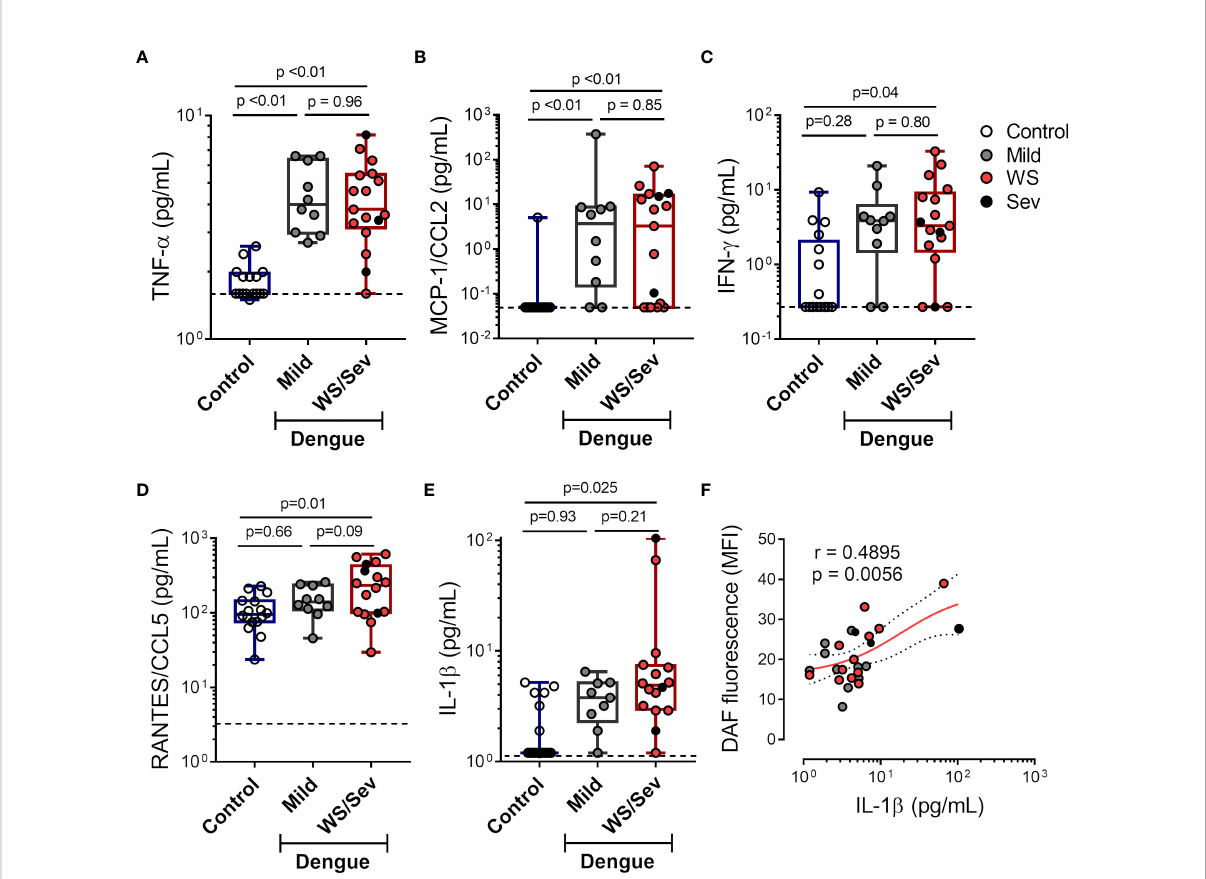
FIGURE 4 Increased levels of pro-in fl ammatory cytokines in plasma from dengue patients. The concentrations of (A) TNF- a (B) MCP-1/CCL2 (C) IFN- ɣ (D) RANTES/CCL5 and (E) IL-1 b were quanti fi ed in plasma from dengue-infected patients with mild (n = 10) or that presented warning signs or severe dengue (n = 18). Each dot represents one patient or healthy volunteer. The horizontal lines in the box plots represent the median, the box edges represent the interquartile ranges, and the whiskers indicate the minimal and maximal values in each group. The dotted lines indicate the lower detection limit of each protocol. (F) NO synthesis in platelets was plotted against the IL-1 b concentration in plasma of each dengue patient. Nonlinear regression was calculated according to the distribution of the